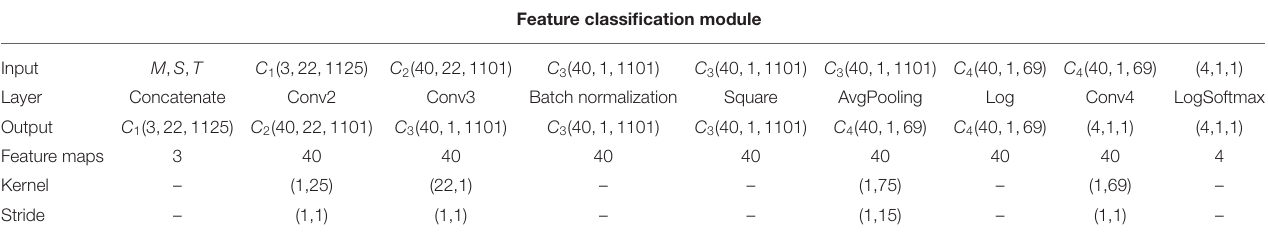
TABLE 3 | Detailed architecture of the proposed temporal self-attention module.